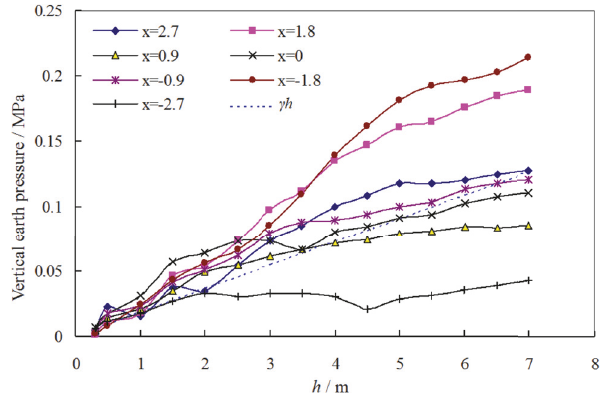
Figure 13: Variation of vertical pressure on the left wall of section I.